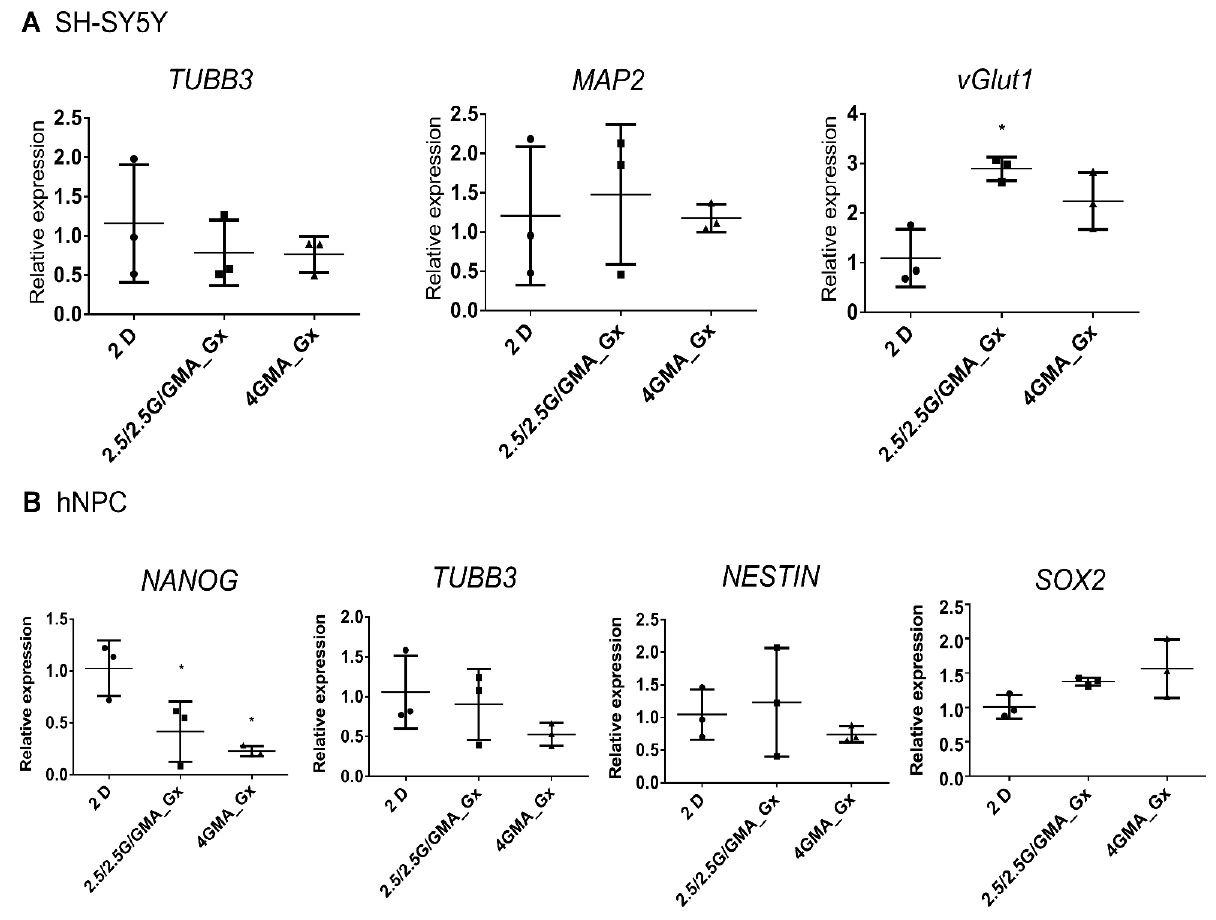
Figure 4. Cells cultured in bioink during 6 days present minor changes in their gene expression profile. In SH-SY5Y, the expression of the vesicular glutamate transporter 1 (vGlut1) was slightly increased in s2.5/2.5G/GMA_Gx ( A ). For hNPCs, there was a significant reduction in NANOG expression in both 2.5/2.5G/GMA_Gx and 4GMA_Gx compared to the 2D control ( B ). * = p < 0.05, one-way Anova plus Tukey post hoc